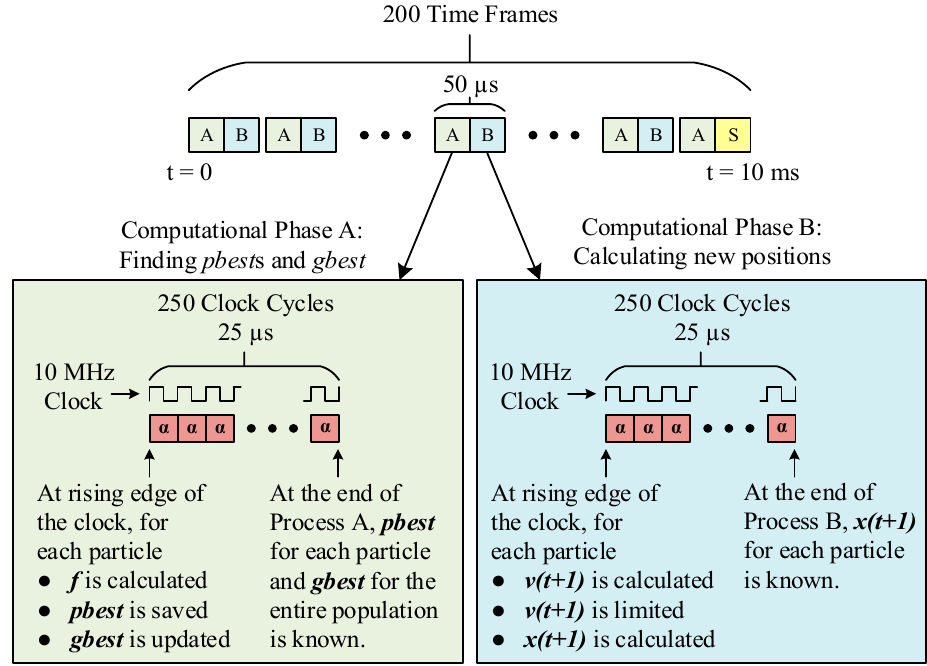
Figure 10. Implementation of the PSO module.